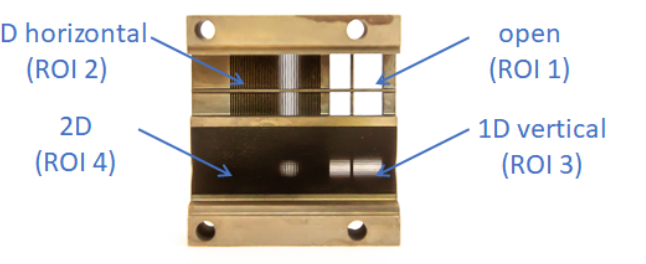
Figure 3. The optical-collimator element of the payload consisting of four segments of distinct response, see text. Size of the entire element 26 mm × 24 mm × 11.4 mm (height) (see Figure 1).